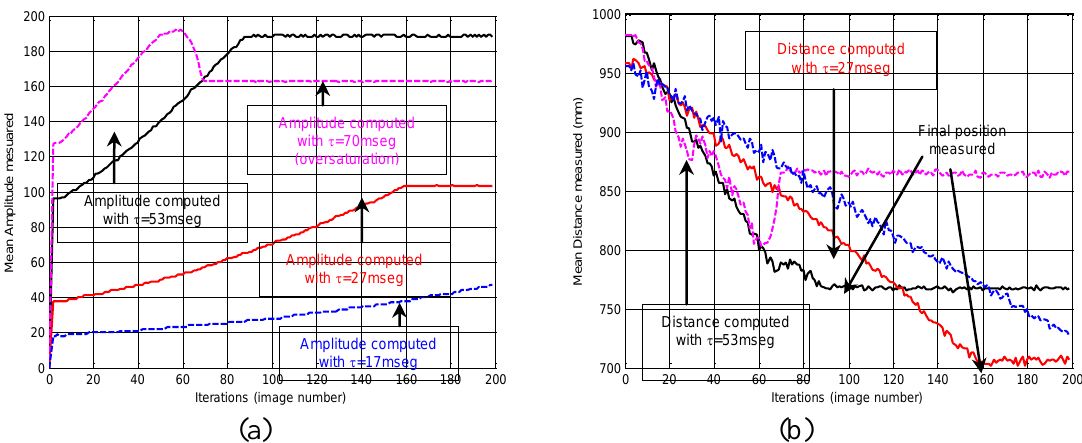
Figure 8. (a) Evolution of the measured amplitude when the integration time is not updated. (b) Evolution of the depth parameter when the integration time is not update.